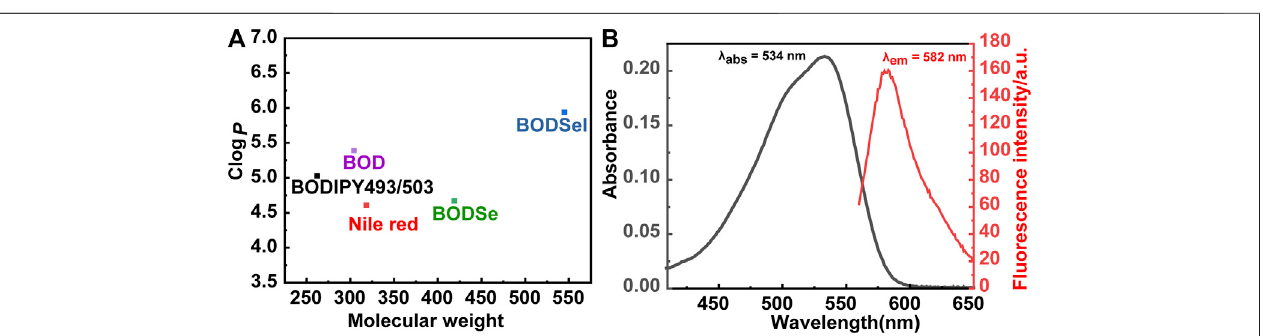
Frontiers in Chemistry |